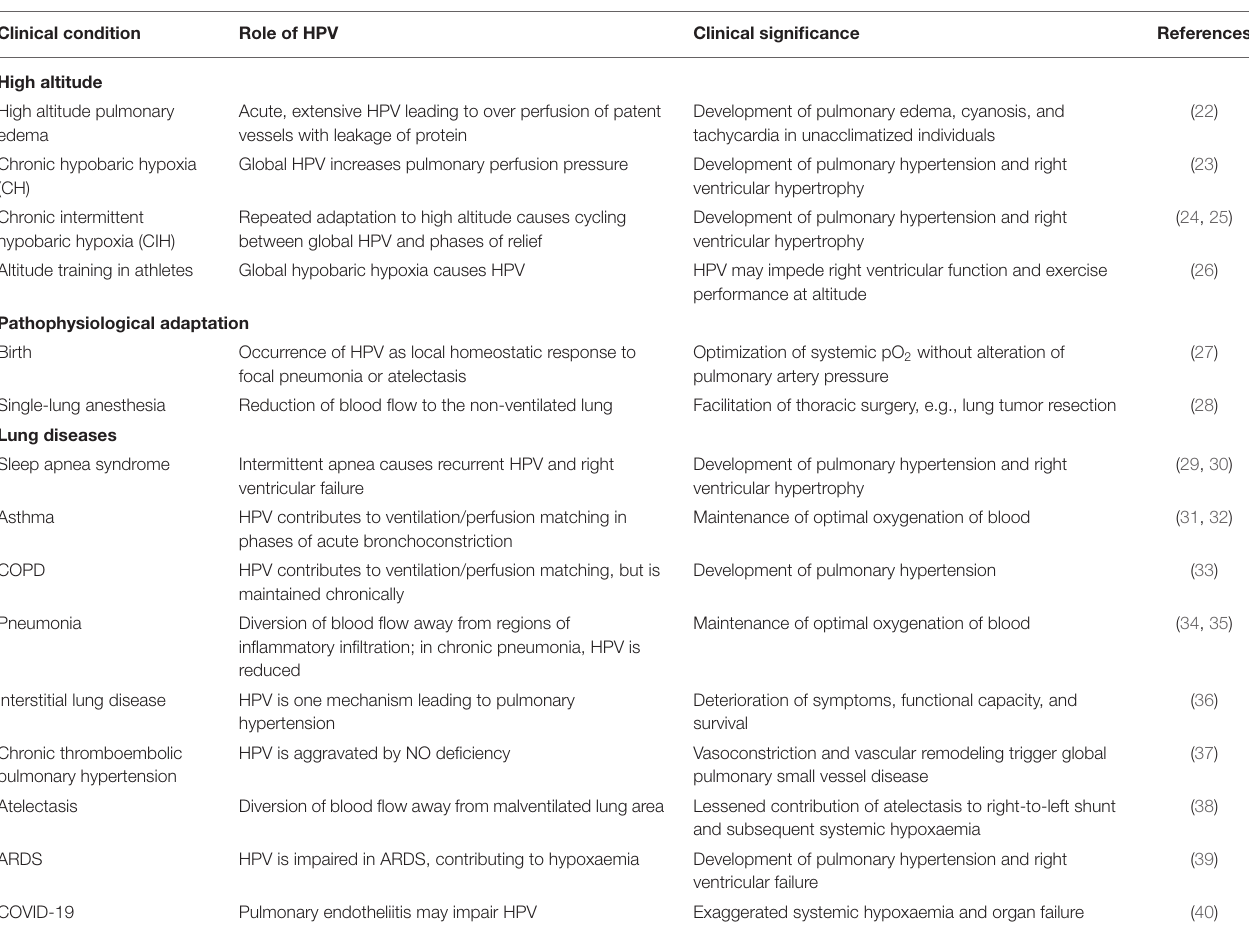
TABLE 1 | Clinical conditions associated with pulmonary